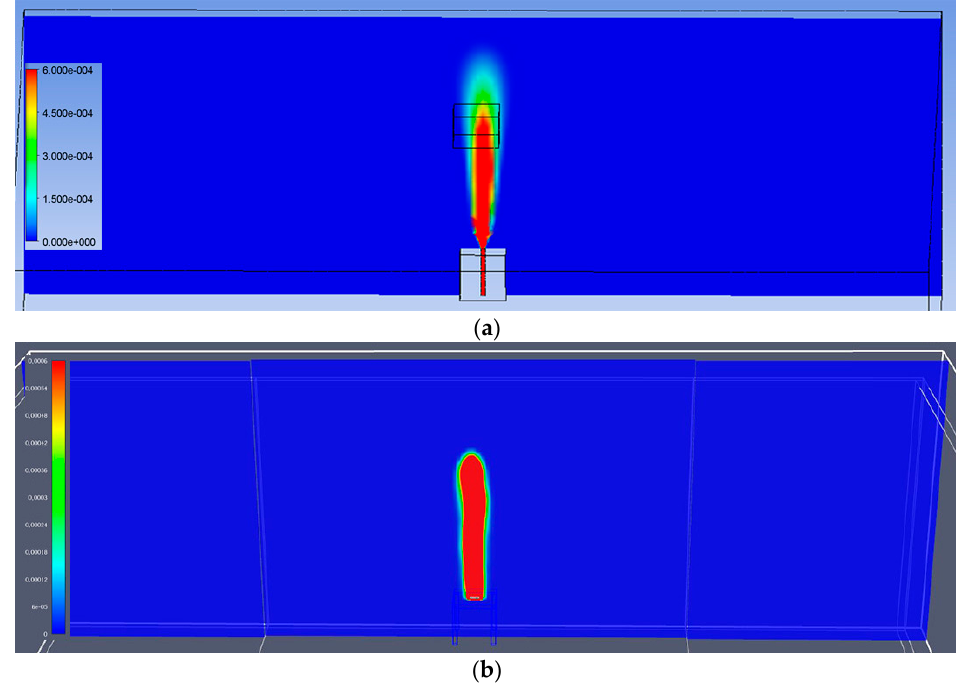
Figure 15. Comparison of hydrogen dispersion for 1.5% concentration of LEL for time 25 s: ( a ) propane release calculated with Ansys software; ( b ) propane release calculated with FDS software. After 50 s, hydrogen reached the ceiling level and spread parallelly. It was observed that FDS software simulated more hydrogen near the ceiling with higher concentration (Figure 16b). The results from Ansys software indicated no appearance of hydrogen at the level of 1.5% LEL (Figure 16a). In the FDS software, it was presented in the area of approx- imately 1 m radius.